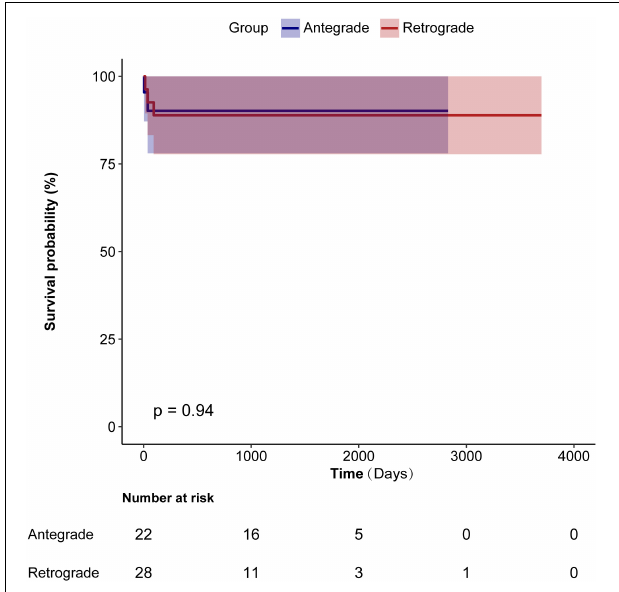
FIGURE 3 | Kaplan-Meier curves show overall survival comparing retrograde group and antegrade